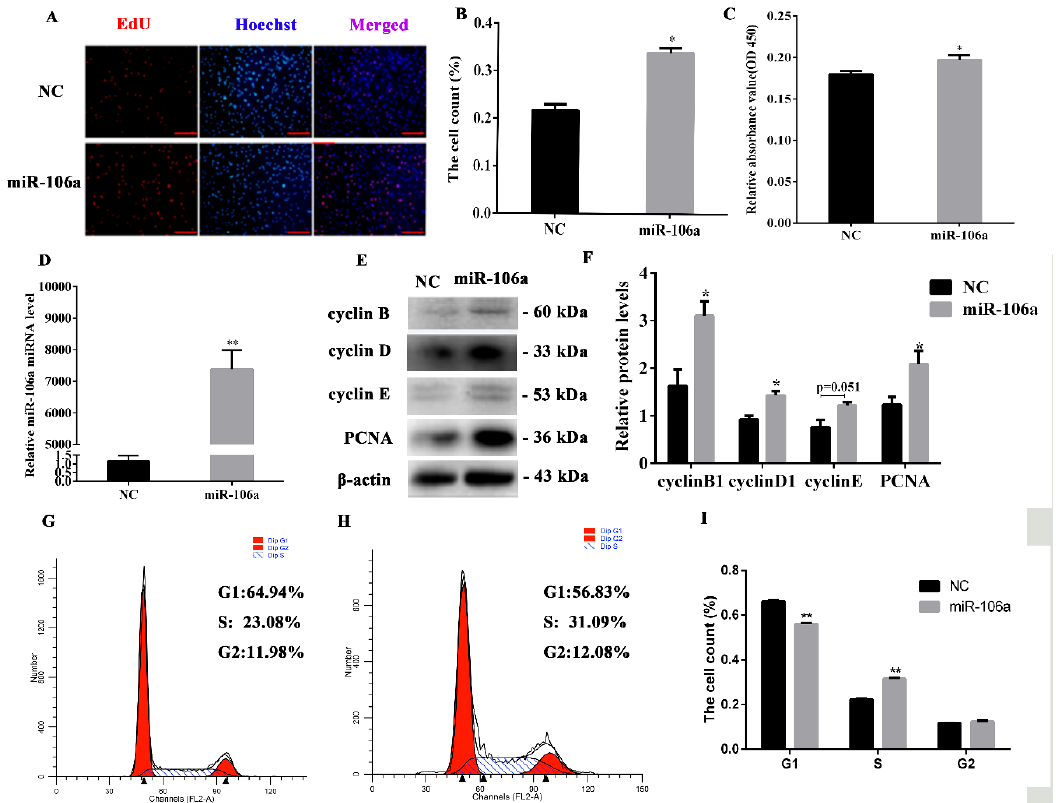
Figure 2. The overexpression of miR-106a promotes porcine preadipocyte proliferation. The miR-106a agomir or negative control (NC) were transfected into cells, and cells were harvested 48 h after transfection. (A,B) 5-Ethynyl-20-deoxyuridine (EdU) staining assayed the number of proliferous cells; positive cells were stained by EdU (red) and total cell nucleus was stained with Hoechst (blue); ( C ) the cell count was measured by cell count kit-8 (CCK-8), and the results illustrated the absorbance value at 450 nm, after incubation with 10% CCK-8 solution for 4 hours; (D) the overexpression efficiency of miR-106a after transfection with the miR-106a agomir compared with NC; ( E ) western blot analysis of cell cycle genes; (F) quantification of the western blot analysis of cyclin B, cyclin D, cyclin E and proliferating cell nuclear antigen (PCNA); (G,H) cell cycle analysis was performed by a flow cytometer; (I) the statistical results of cell cycle analysis. Data are representative of the mean ± SEM of three independent experiments; scale bar: 100 μ m; * p < 0.05, ** p < 0.01.